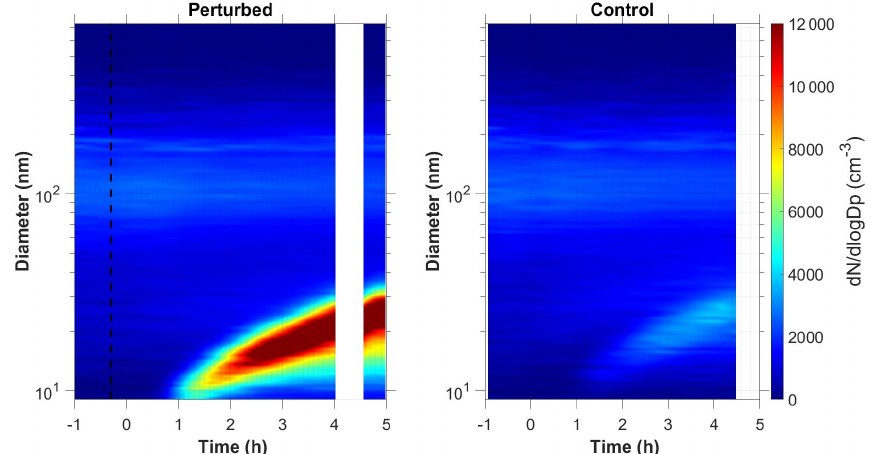
Figure 3. Wall loss corrected measured number distributions in the two chambers for Exp. B1.